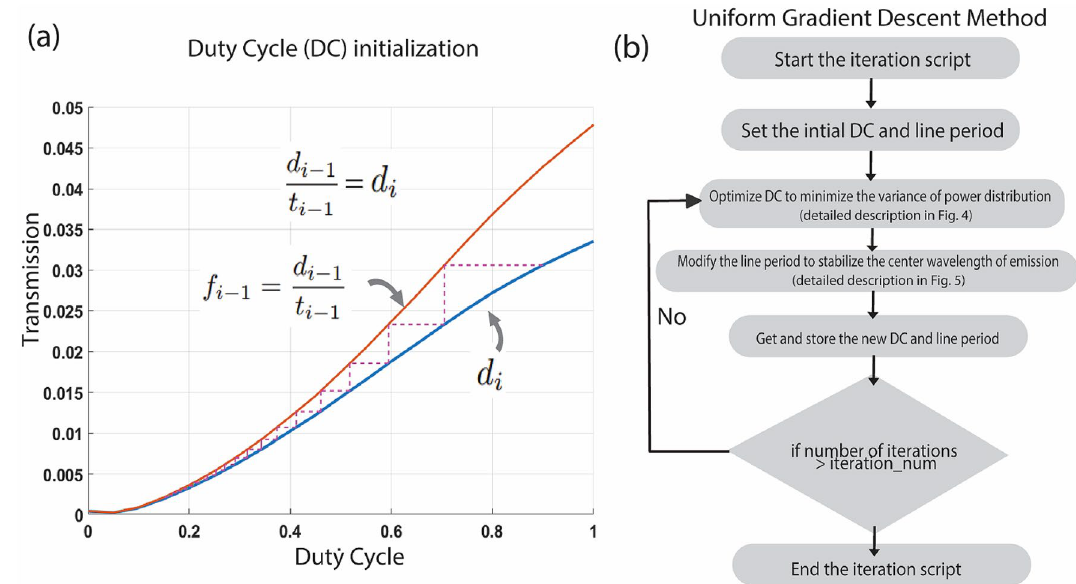
Figure 3. This is the control flow chart of the iteration algorithm. We first set the initial duty cycle and row period, then use gradient descent method to tune the duty cycle and optimize the variance of power distribution. This may cause a shift in central wavelength; thus, we modify the groove period to stabilize it. We obtain a duty cycle and groove period in every loop and iterate until termination constraints are